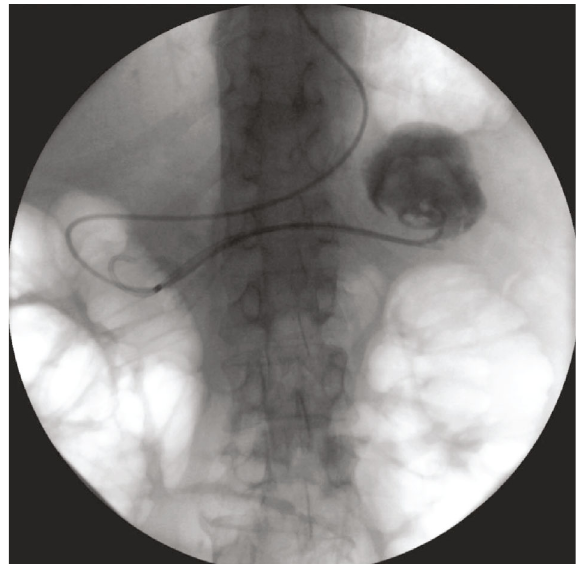
Figure 7: Active transpapillary drainage of a pseudocyst located in the pancreatic